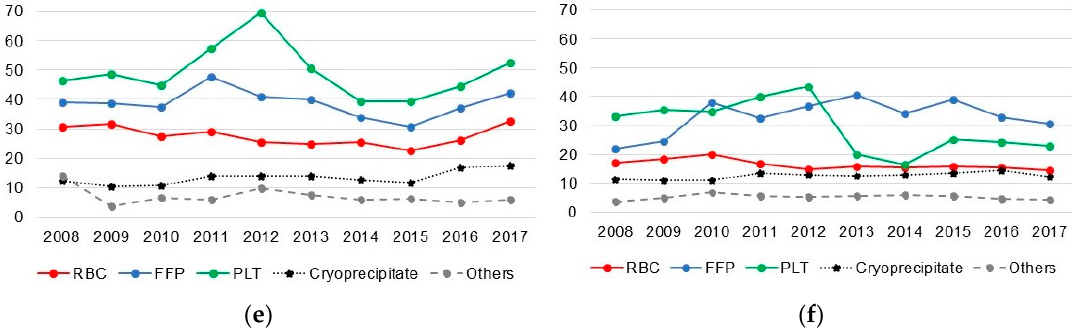
Figure 1. Proportion of transfusion, average count, and amount of transfusion in liver recipients by type of donor, 2008–2017. ( a ) Proportion transfusion among deceased liver donor recipients; ( b ) Proportion transfusion among living liver donor recipients; ( c ) Average count of transfusion among deceased liver donor recipients; ( d ) Average count of transfusion among living liver donor recipients; ( e ) Average amount of transfusion among deceased liver donor recipients; ( f ) Average amount of transfusion among living liver donor recipients. RBC: red blood cells; PLT: platelet; FFP: fresh frozen plasma.